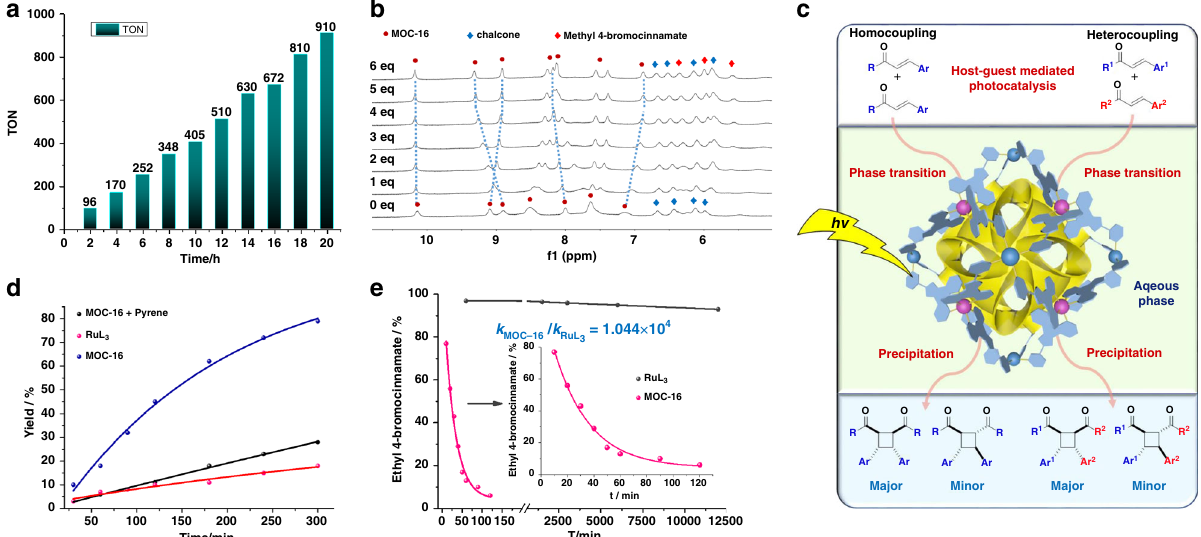
Fig. 4 Catalytic study. a Accumulative TONs of production of 50 by 1 mol% MOC-16 with successive addition of 10 portions of substrates in every 2 h without isolation of photocatalyst. b 1 H NMR titration of methyl 4-bromocinnamate into a 5× chalcone ⊂ MOC-16 host-guest system (400 MHz, DMSO- d = 1:3, 298 K) showing co-encapsulation of these two different substrates. c Schematic illustration of host-guest mediated photocatalysis of 6 : D 2 O, v-v selective homo- and heterocoupling [2 + 2] cycloaddition through an aqueous phase transition expedited process. d Inhibition of [2 + 2] dimerization of methyl cinnamate by adding 10 eq competing pyrene guests. e Reaction kinetics of ethyl 4-bromocinnamate dimerization catalyzed by 0.08 mol% MOC-16 or 0.64 mol% RuL 3 under similar split of the host and substrate are observed in DMSO- d 6 -D 2 O (1: